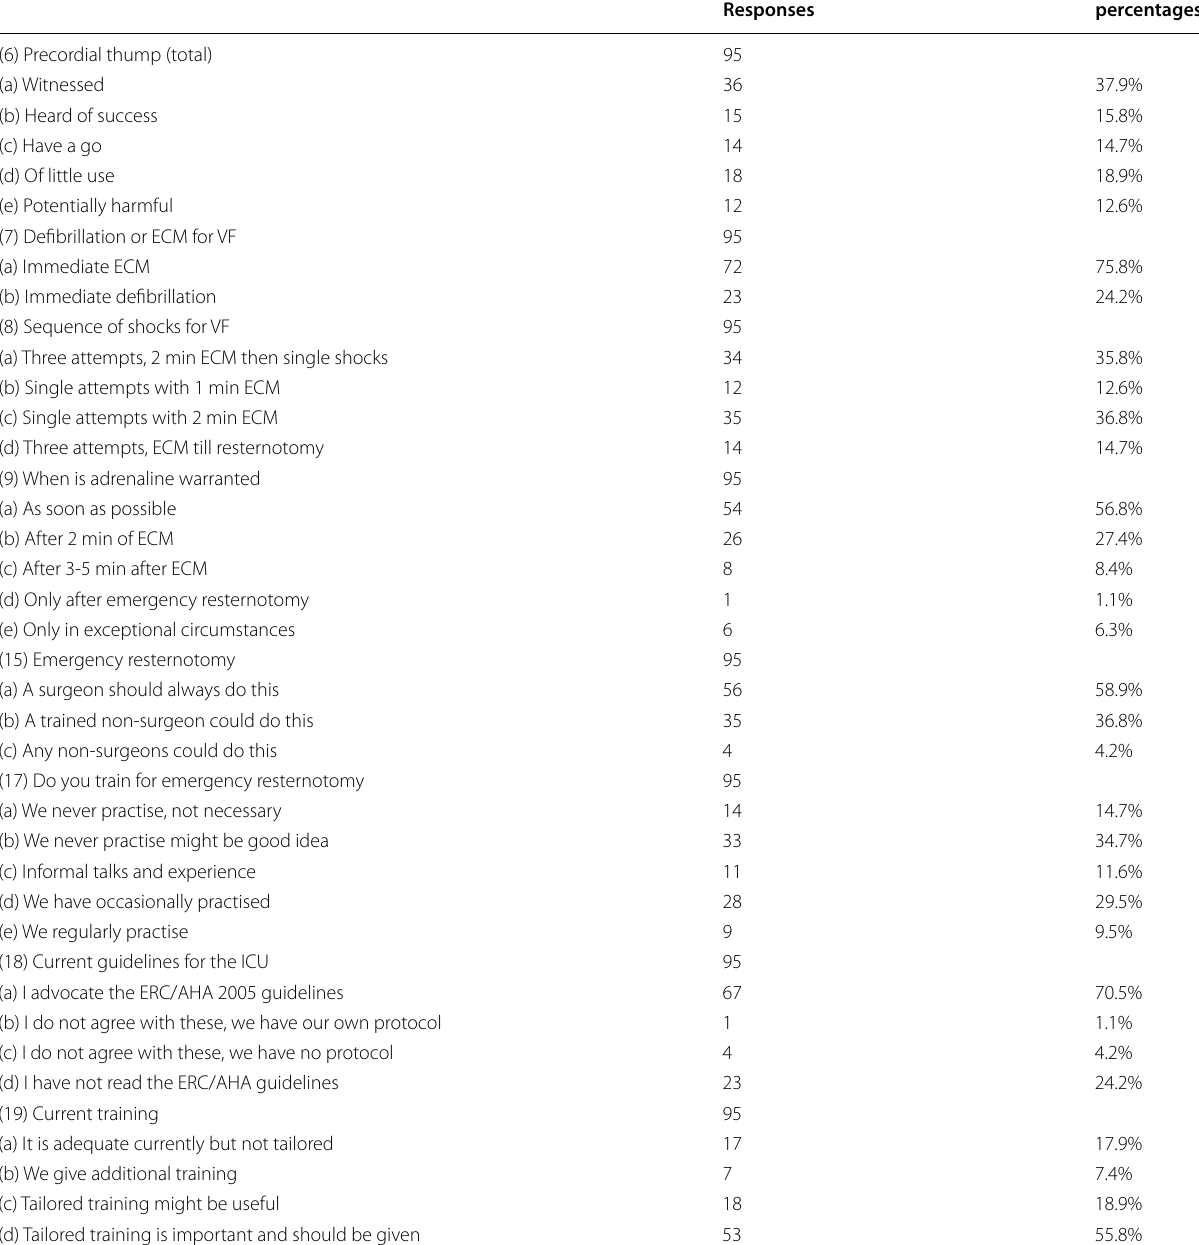
Table 3 A series of questions on the conduct of an emergency resternotomy in patients who suffered a cardiac